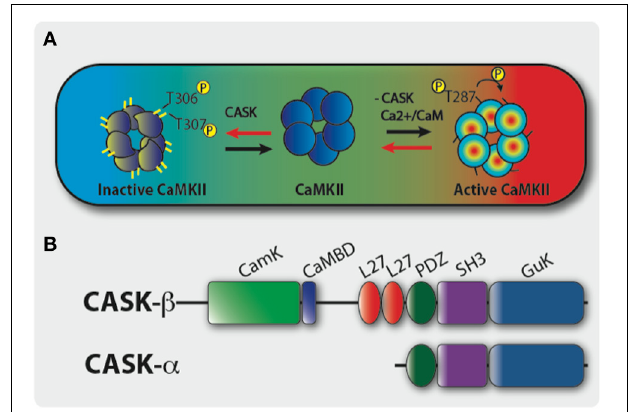
FIGURE 1 | A model of CASK’s regulation of CaMKII autophosphorylation during memory formation. (A) The large colored rectangle represents a hypothetical neuron in the middle of which is a cartoon of a single layer of a CaMKII dodecamer holoenzyme. On the right, under conditions of increased synaptic activity (high [Ca 2 + ], in red) Ca 2 + /CaM binds CaMKII via the CaM binding site that contains the inhibitory T306 T307 sites hence blocking them from autophosphorylation. This also promotes T287 autophosphorylation (pT287) and the switch to persistently high kinase activity even after Ca 2 + levels fall. On the left, under conditions of low synaptic activity and low [Ca 2 + ] (in blue), there is low probability of CaM binding to CaMKII allowing CASK to promote autophosphorylation of the inhibitory T306 T307 (pT306 pT307) sites. This renders the kinase inactive and even if there is a subsequent increase in Ca 2 + /CaM, CaM binding is blocked by pT306 pT307 in the CaM site. Eventually phosphatases will act to remove phosphorylation events and return endogenous CaMKII to its basal state. Therefore, in the absence of CASK there is a decrease in inhibitory pT306 pT307 and an increase in pT287 constitutively active CaMKII, conversely increased CASK promotes inhibitory pT306 pT307 decreasing pT287 and endogenous CaMKII activity. Therefore, neurons expressing transgenic CaMKII with inhibitory phosphorylation sites mutated to blocking residues (TT306/7AA) or with too little CASK due to mutation results in a form of CaMKII that is unable to switch off. This causes abnormally high CaMKII activity that subsequently interferes with the physiology of the neuron disrupting memory. (B) Predicted domain structure of CASK isoforms, the short isoform CASK- α contains PDZ, SH3, and GUK domains while the long isoform CASK- β contains additional CaMK-like (CamK), Calmodulin binding domain (CaMBD), and L27 domains at its N-terminus. The CASK- β null contains a N-terminal deletion removing CaMK, CaMBD, and L27 domains but leaves the downstream promoter and whole of CASK- α intact (Slawson et al.,